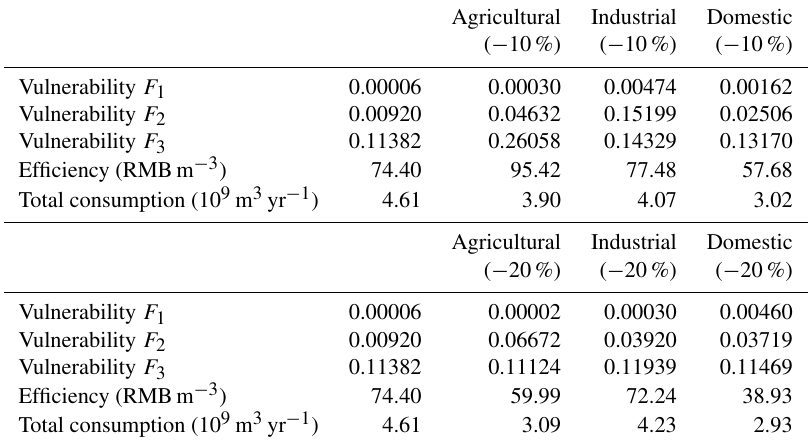
Table 6. Optimal results under varying import crops’ prices.